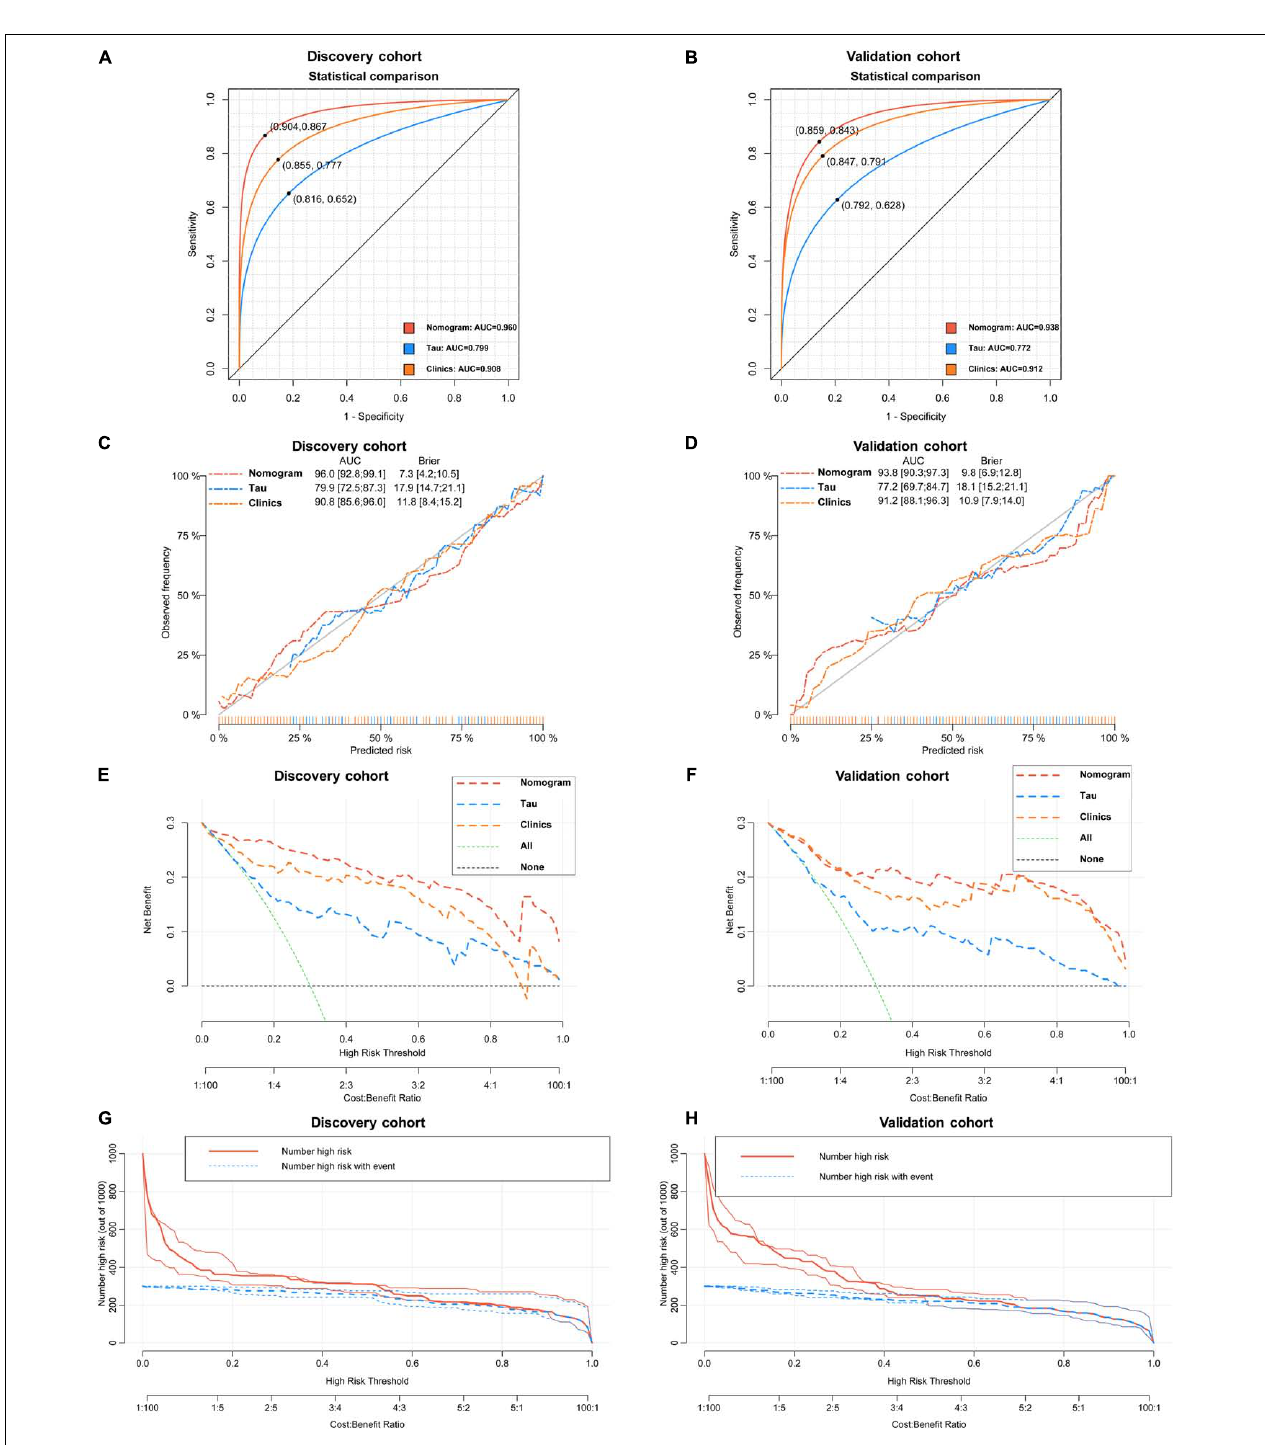
FIGURE 6 | Statistical performance and clinical application of the nomogram. (A) Novel nomogram outperforms total Tau in plasma and Clinical model for discriminating AD patients and non-MCI participants in discovery cohort [ (A) 0.960 vs. 0.799 and 0.908, P < 0.05] and validation cohort [ (B) 0.938 vs. 0.772 and 0.912, P < 0.05]. Cross-validated calibration curves of the three models in discovery cohort (C) and validation cohort (D) . Decision curve analysis demonstrating the net benefit associated with using the novel nomogram in discovery cohort (E) and validation cohort compared to total and Clinical model (F) . Clinical impact curves of the nomogram model in discovery cohort (G) and validation cohort (H) . The red curve (number of high-risk participants) indicates the number of people who are identified as AD (high risk) by the nomogram at each threshold probability; the blue curve (number of high-risk with event) is the number of true diagnoses at each threshold